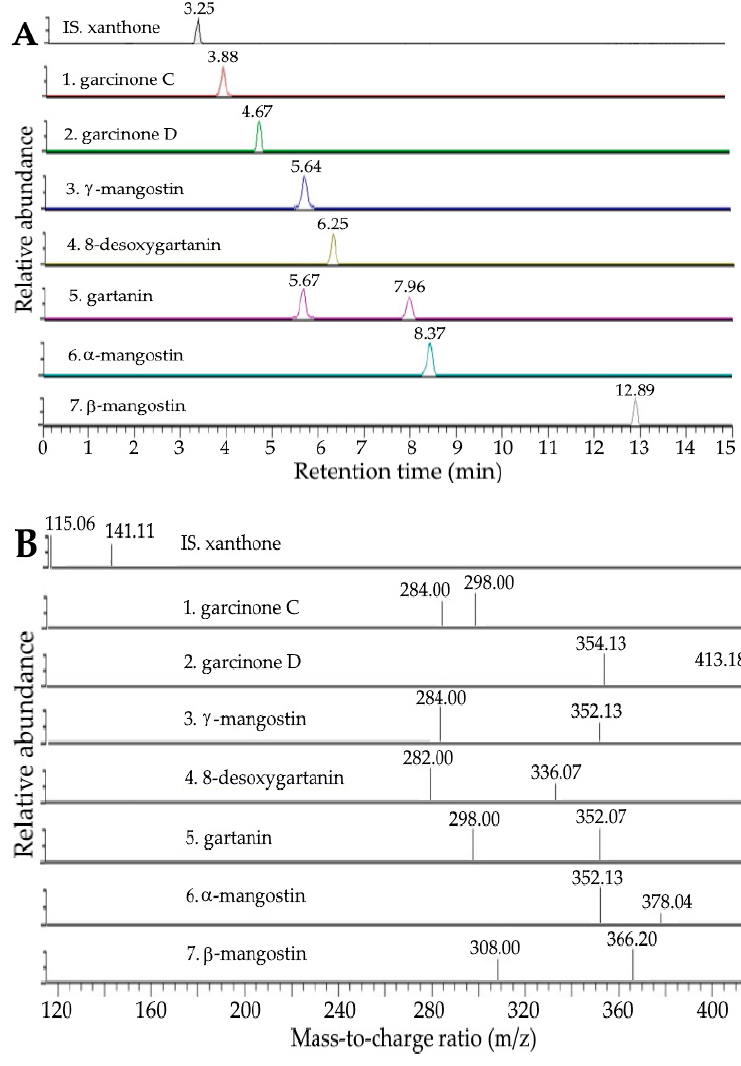
Figure 1. UPLC-MS/MS chromatograms of xanthone standards and internal standard (xanthone) as detected by SRM mode ( A ) and their corresponding tandem mass spectra ( B ).